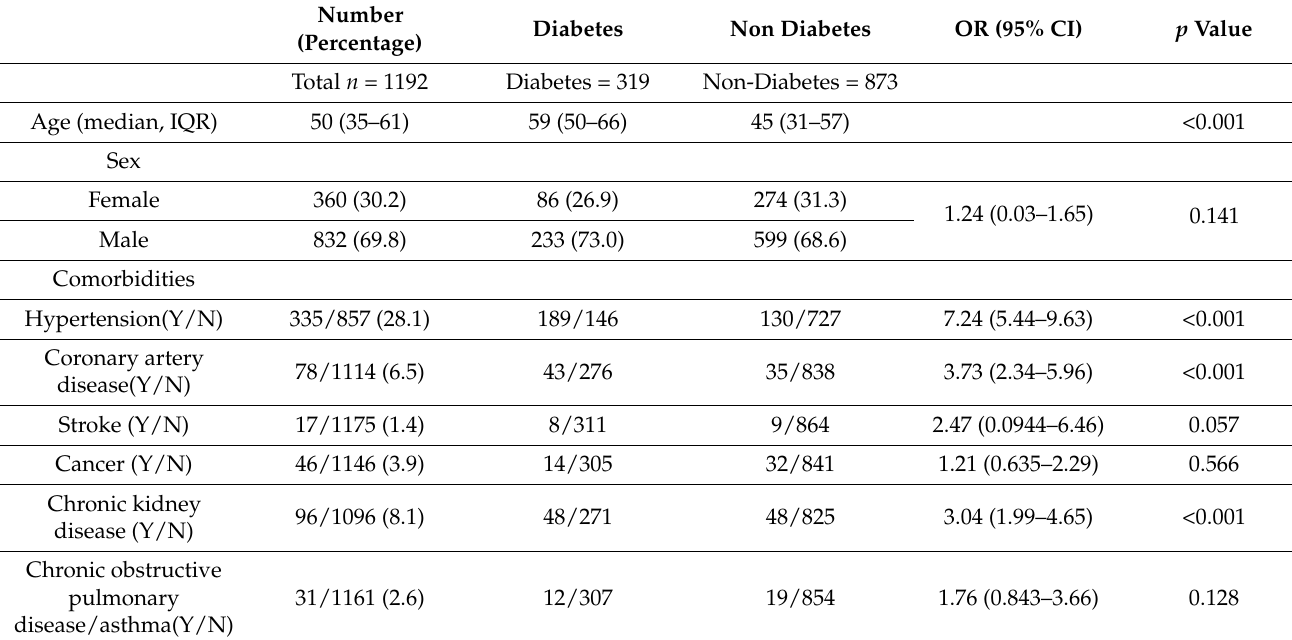
Table 1. Baseline patient characteristics in patients with and without diabetes.